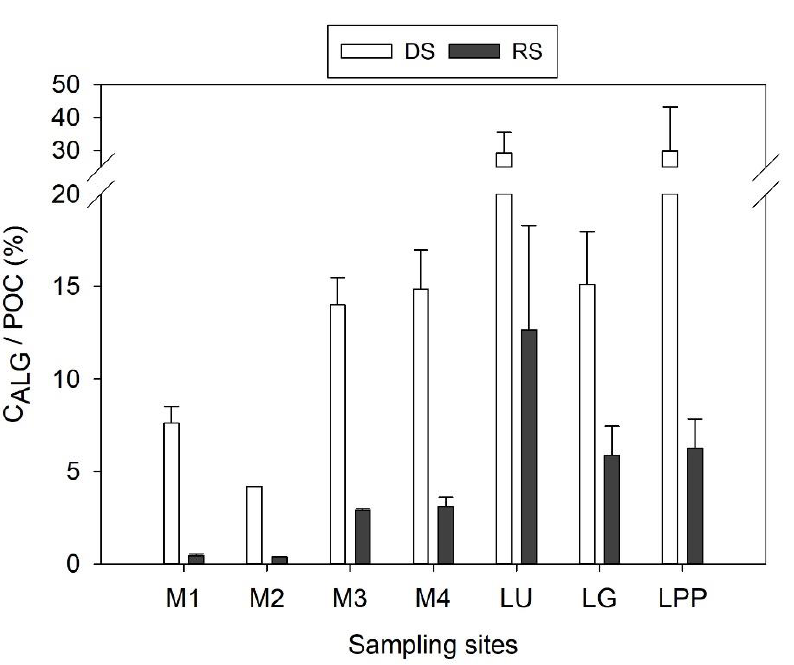
Figure 4. Contribution of algal biomass to POC throughout the Usumacinta River basin during the dry (DS) and rainy (RS) seasons. Bars represent averages and the whiskers represent the standard deviations.